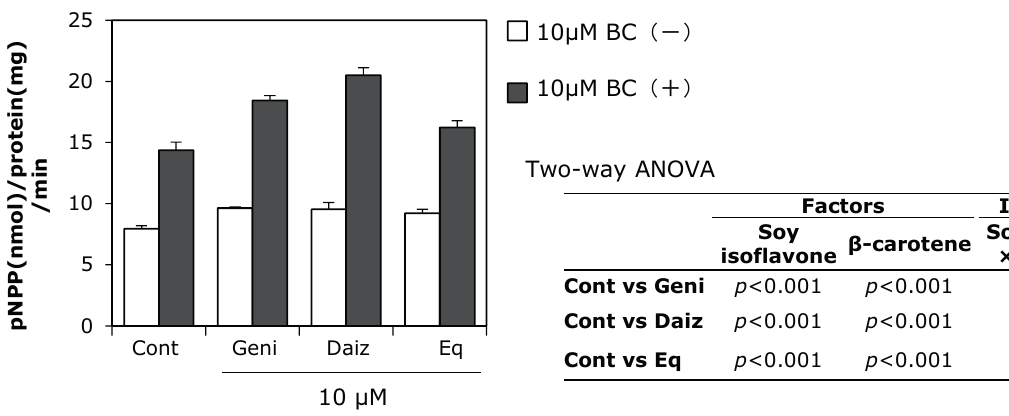
Figure 2. Combined effect of soy isoflavones with β -carotene on ALP activity. MC3T3-E1 cells were precultured in α -MEM/10% FBS for 24 h and subsequently cultured in medium with 10% charcoal-treated FBS containing 10 μ M of soy isoflavones with (black bars) or without (open bars) 10 μ M of β -carotene (BC) for nine days. Data are expressed as means ± SEM ( n = 4). Statistical analysis was performed using two-way ANOVA with the two factors being soy isoflavones (control: Cont., daidzein: Daiz., genistein: Geni., and equol: Eq.) and β -carotene (BC). Significance was set at p <